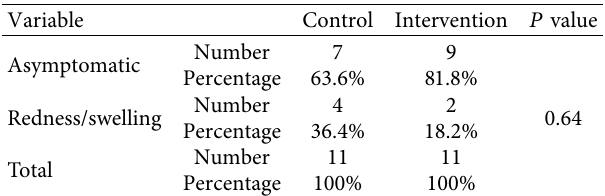
Table 3: Te frequency of clinical symptoms in the two groups at the second treatment session.